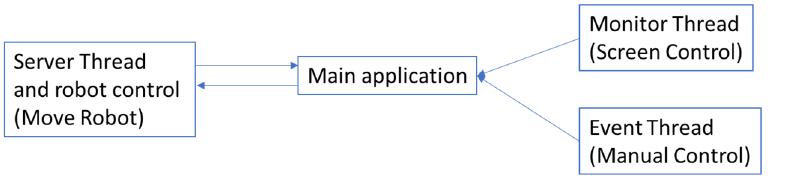
Figure 11. Program execution